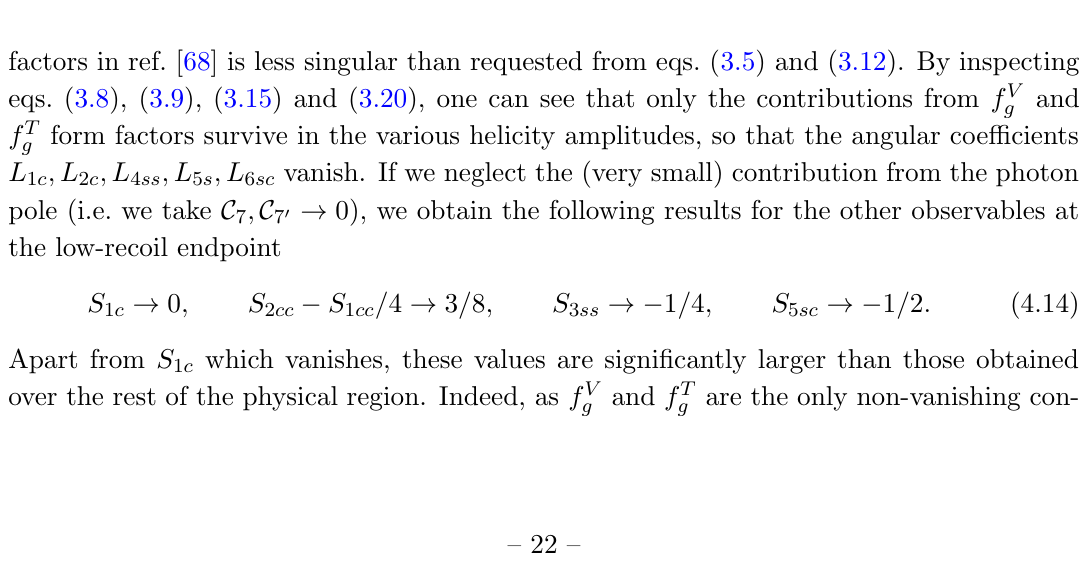
Figure 4 . Variation of S 1 c (top) and S 2 cc (cid:0) S 1 cc = 4 (bottom) with respect to the dilepton invariant mass, in the case of the SM and three NP